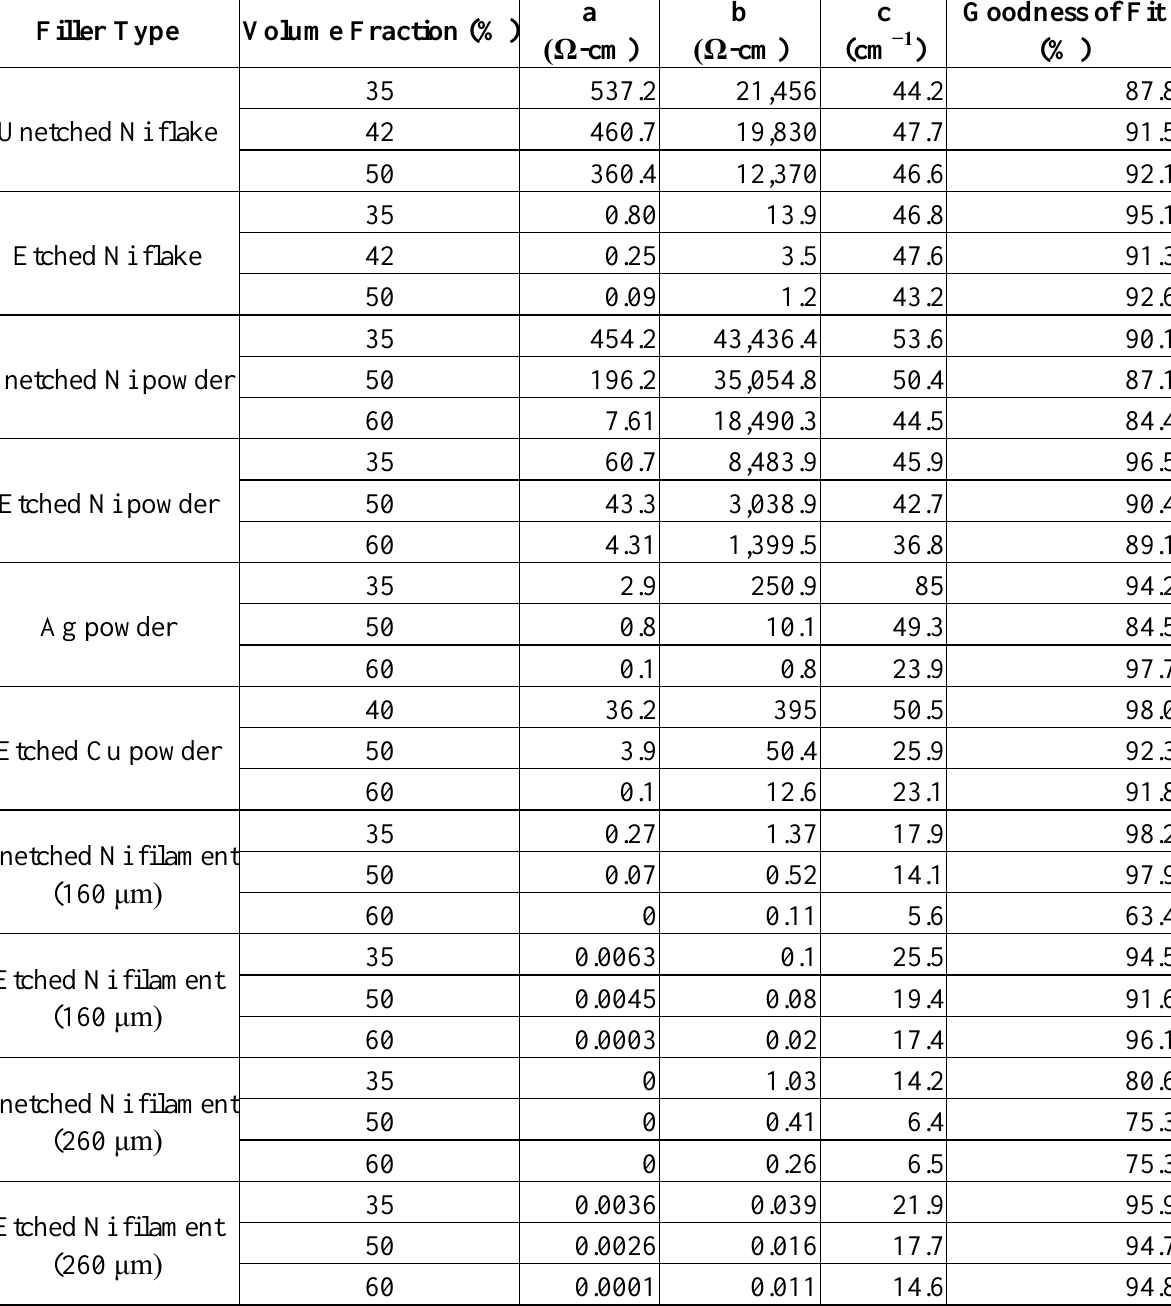
Table 1. The material parameters of the decaying exponential function  = a + b × Exp (−ct) describing the thickness-dependent conduction behavior with various conductive particles in Epon 815C